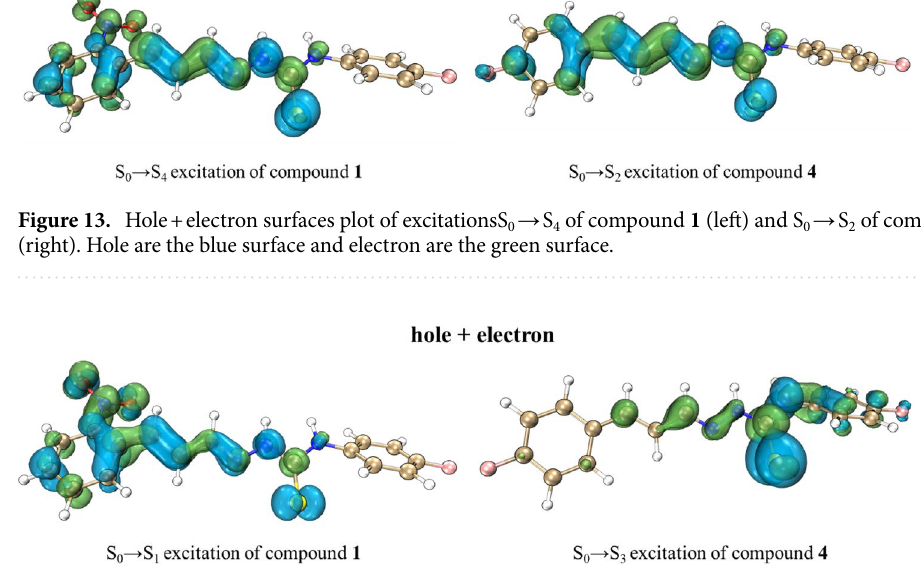
Figure 14. Hole + electron surfaces plot of excitationsS 0 → S 1 of compound 1 (left) and S 0 → S 3 of compound 4 (right). Hole are the blue surface and electron are the green surface.